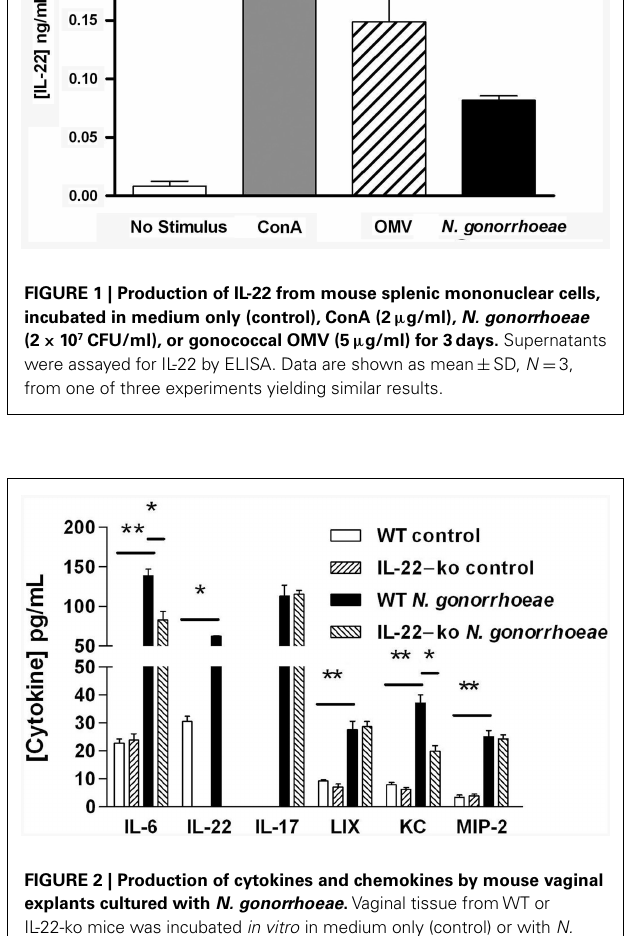
whereas production of MIP-2 α (CXCL2) and LIX (CXCL5)